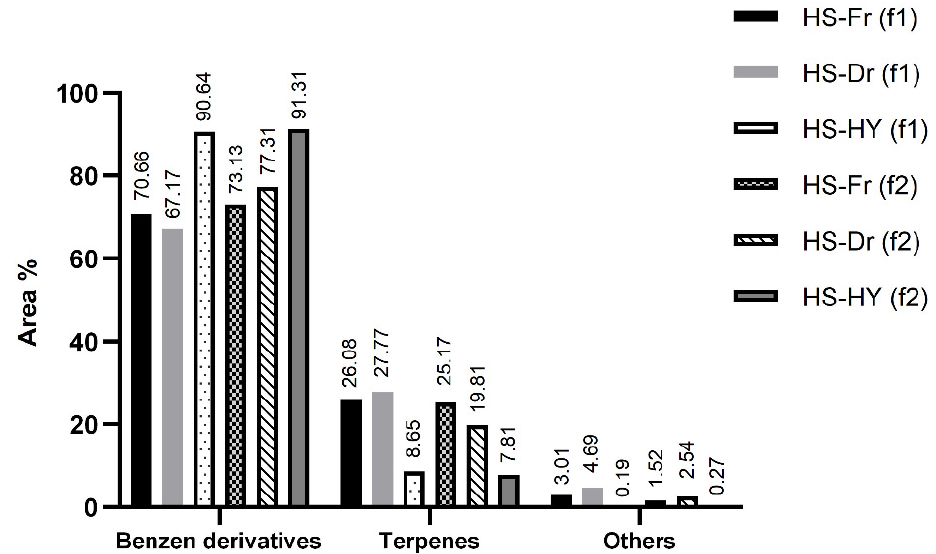
divinylbenzene/carboxene/polydimethylsiloxane fibre (f1); polydimethylsiloxane/divinylbenzene fibre (f2); HS-Fr—fresh P. ramosissima ; HS-Dr—air-dried P. ramosissima ; HS-HY—hydrosol of air- dried P. ramosissima.